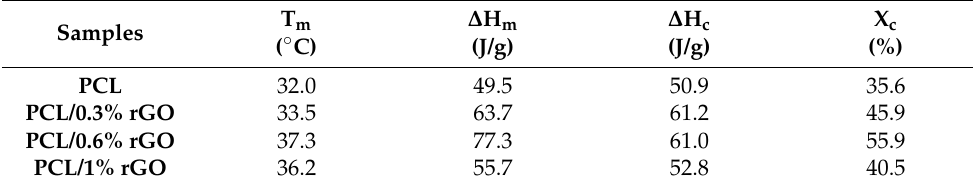
Table 1. Thermal properties of PCL and PCL/rGO composite scaffolds.